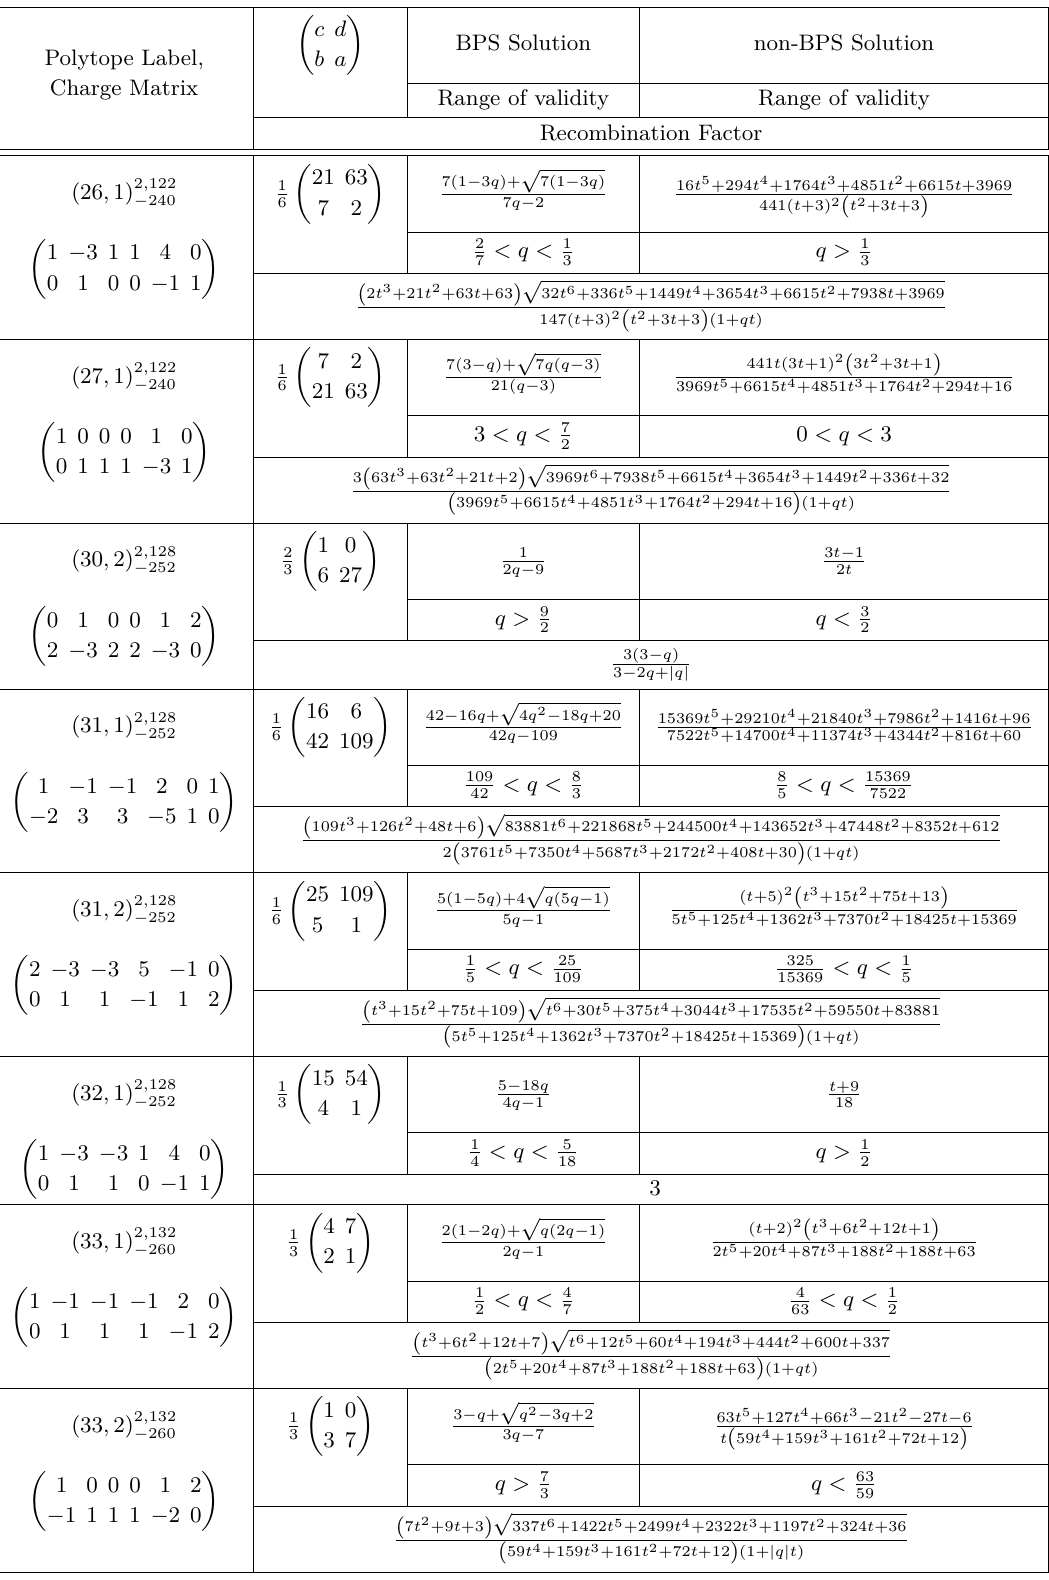
Table 7 . BPS and non-BPS extremal black holes in one-modulus THCY models,